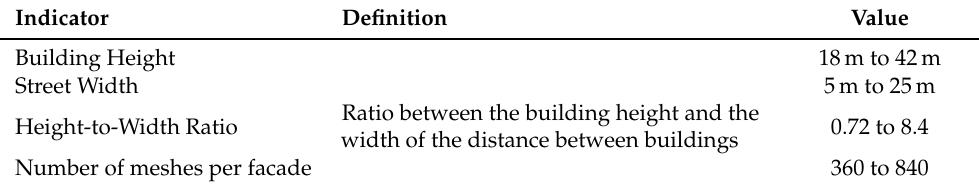
Table 4. Urban morphology indicators specific to the heterogeneous